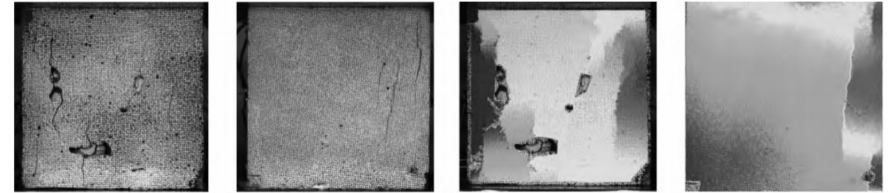
Figure 10. Typical failure modes of cubic specimens [77], with copyright permission from Elsevier.